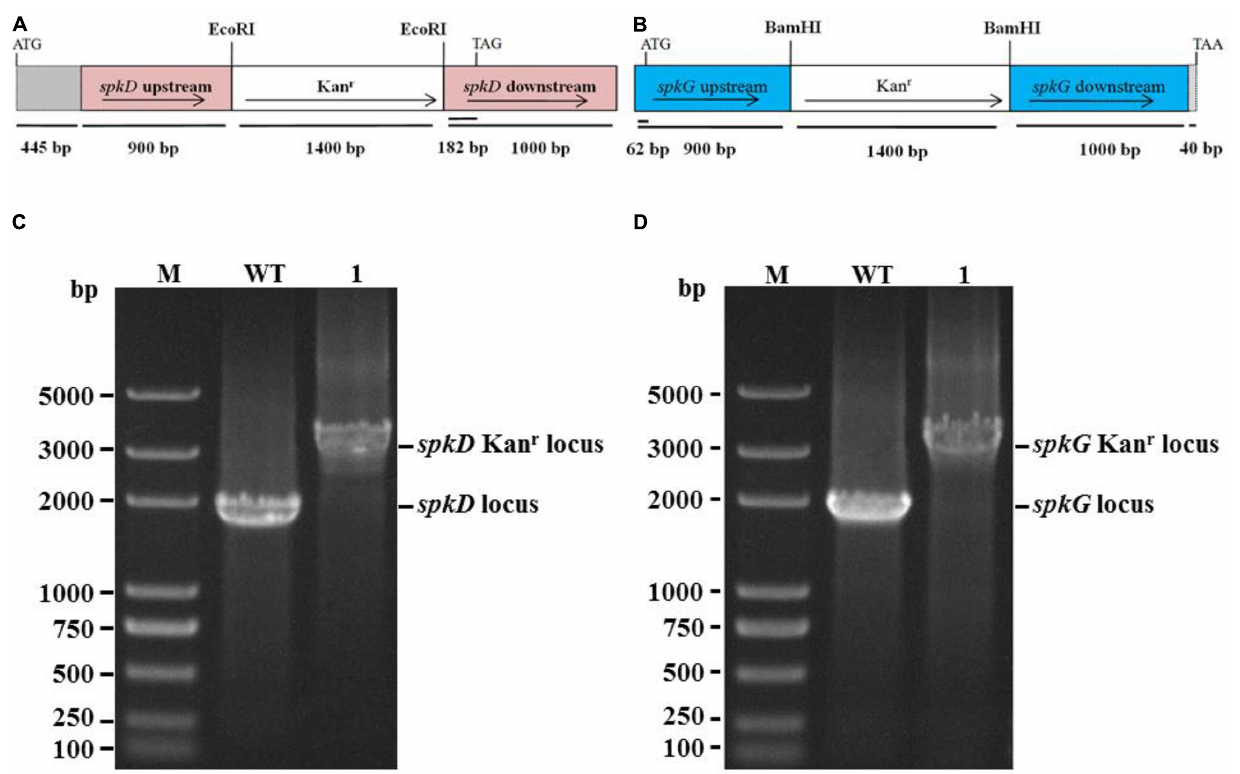
FIGURE 1 | Construction of Synechocystis spkD and spkG gene knockout vectors and PCR detection of mutant strains. (A) Diagram of the spkD gene-directed knockout vector. The gray region (445 bp) shows the unamplified area in the ORF of spkD ; (B) Diagram of the spkG gene-directed knockout vector. The gray region (40 bp) shows the unamplified area in the ORF of spkG ; (C) PCR detection of spkD gene-directed knockout, M: Trans 2K plus DNA Marker, WT: spkD gene in wild type Synechocystis , Lane 1: spkD gene knockout mutant; (D) PCR detection of spkG gene knockout, M: Trans 2K plus DNA Marker, WT: spkG gene in wild type Synechocystis ; Lane 1: spkG gene knockout